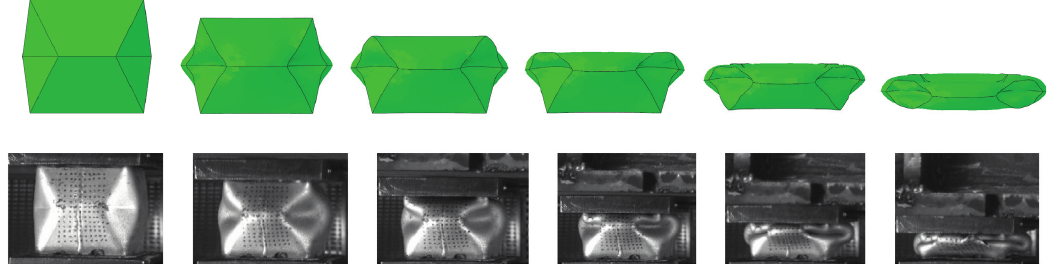
Figure 4: Comparison between numerical simulation and the experimental deformation